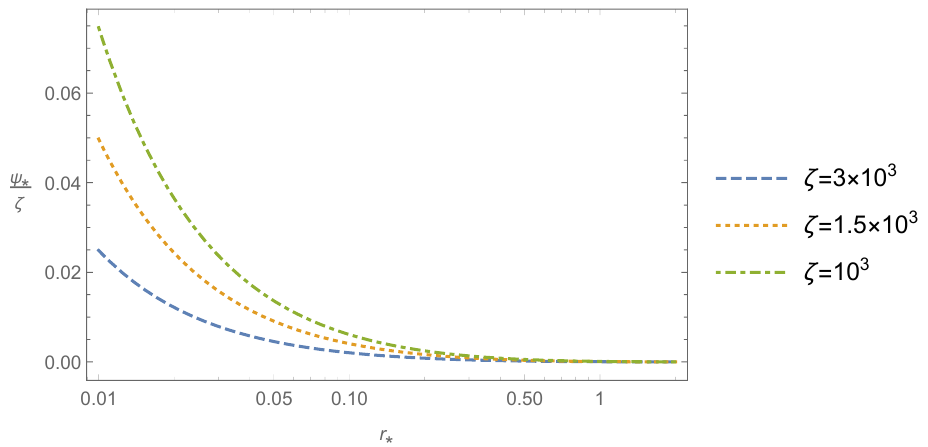
Figure 2. ψ ∗ / ζ as function of r ∗ for β = 0.1, µ = 0.004 and ζ = 1.0 × 10 3 ; 1.5 × 10 3 ; 3.0 × 10 3